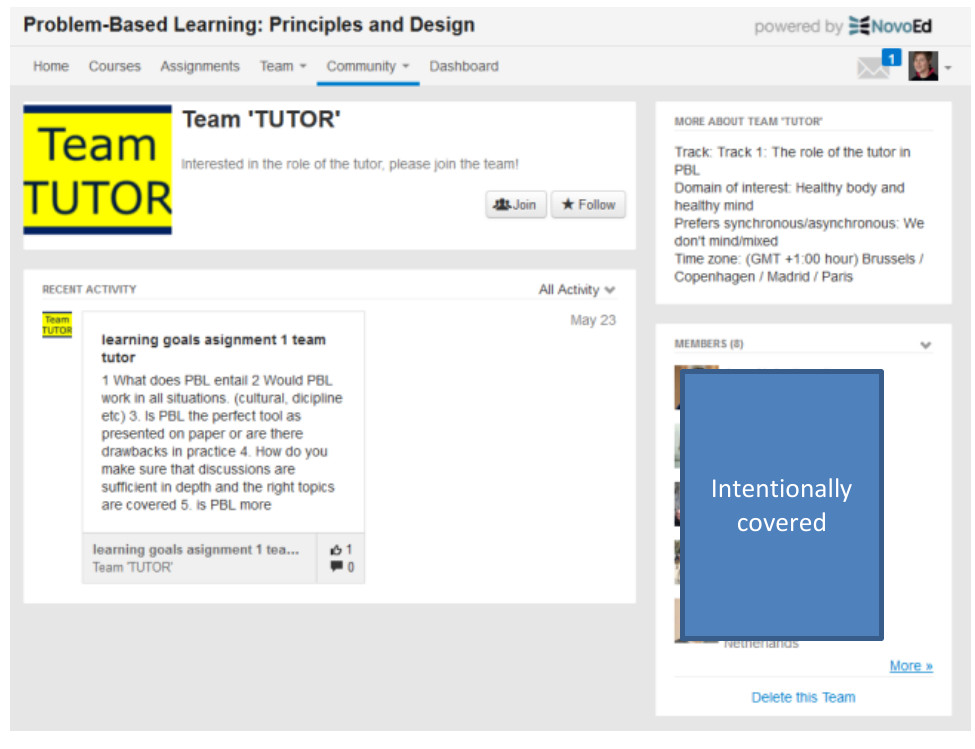
Figure 1. Team space with public profile page and private chat facilities, file exchange and facilities to schedule